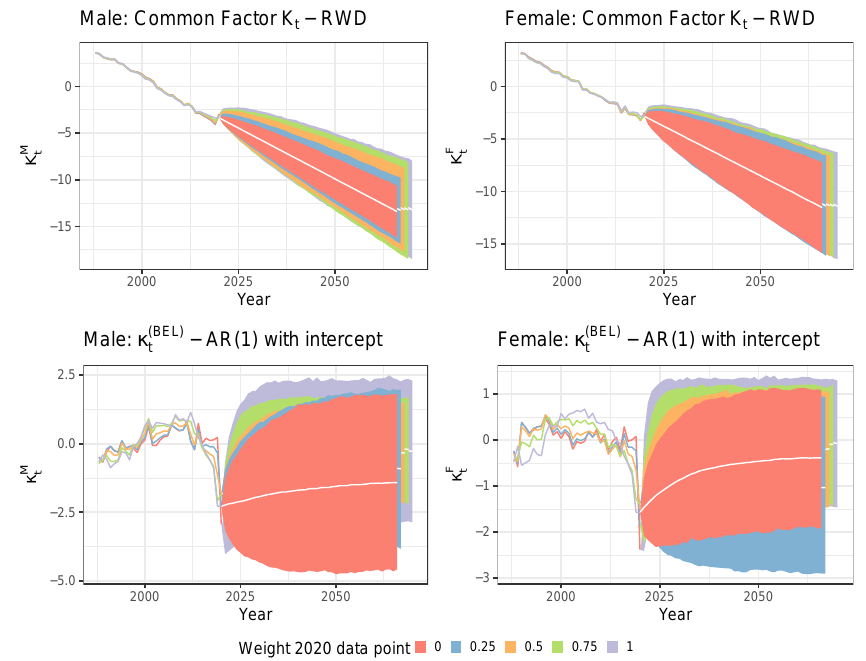
Figure 13. Projection of the calibrated time dependent parameters in the adjusted Lee and Miller model: ˆ K t ( top ) and ˆ κ t ( bottom ). Male ( left ) and female ( right ) data, calibration period 1988–2020 and projection period 2021–2070, method of Section 5.2. We show the 0.5%, median (white lines) and 99.5% quantile, based on 10,000 simulations across each weighting scenario. The coloured, solid lines visualize the calibrated period effects for each weighting scenario: ˆ K t and ˆ κ t .white space white space white space white space white space white space